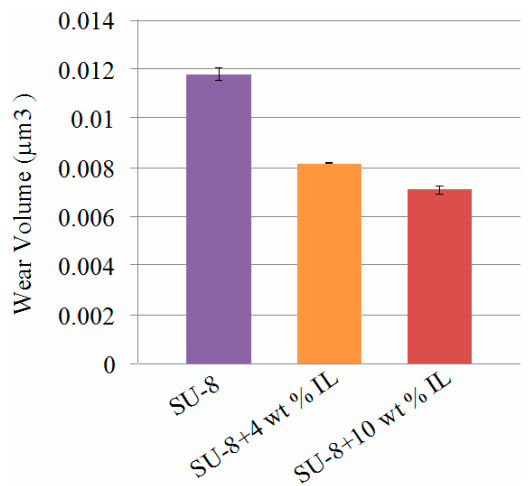
Figure 6. Wear volume after 1800 cycles for pristine SU-8, composite with 4% and 10% IL. A decreasing trend is observed as a result of addition of lubricant.